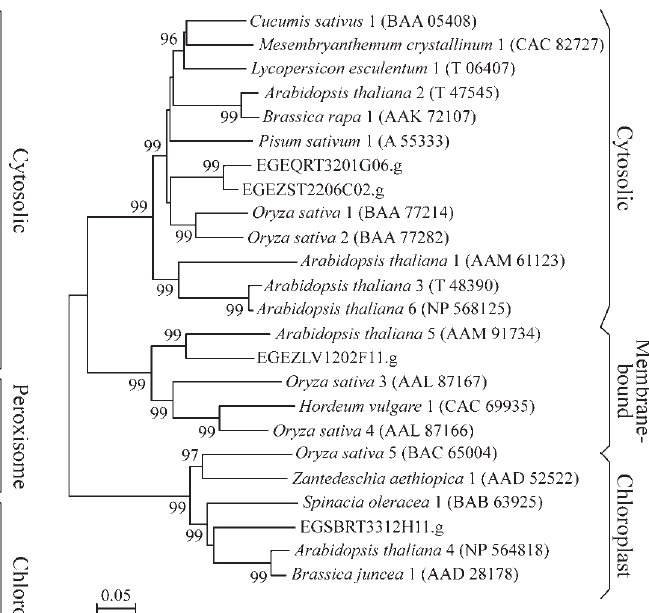
Figure 5 - Phylogenetic tree of MDHAR proteins. Phylogenetic analyses were conducted as described in Figure